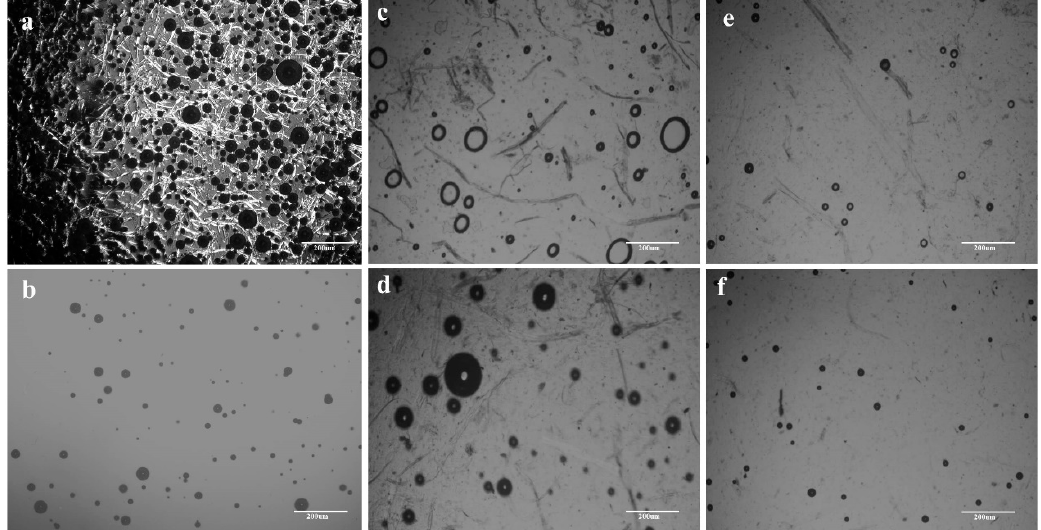
Figure 2. ( a – d ) POM micrographs of CP/AmimCl solution at 80 °C after ( a ) 0 min and ( b ) 60 min, and WCCs/AmimCl solution at 80 °C after ( c ) 0 min, ( d ) 30 min, ( e ) 60 min, and ( f ) 240 min.